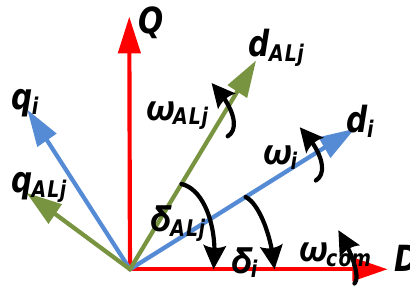
Figure 4. Common reference frame ( DQ ).